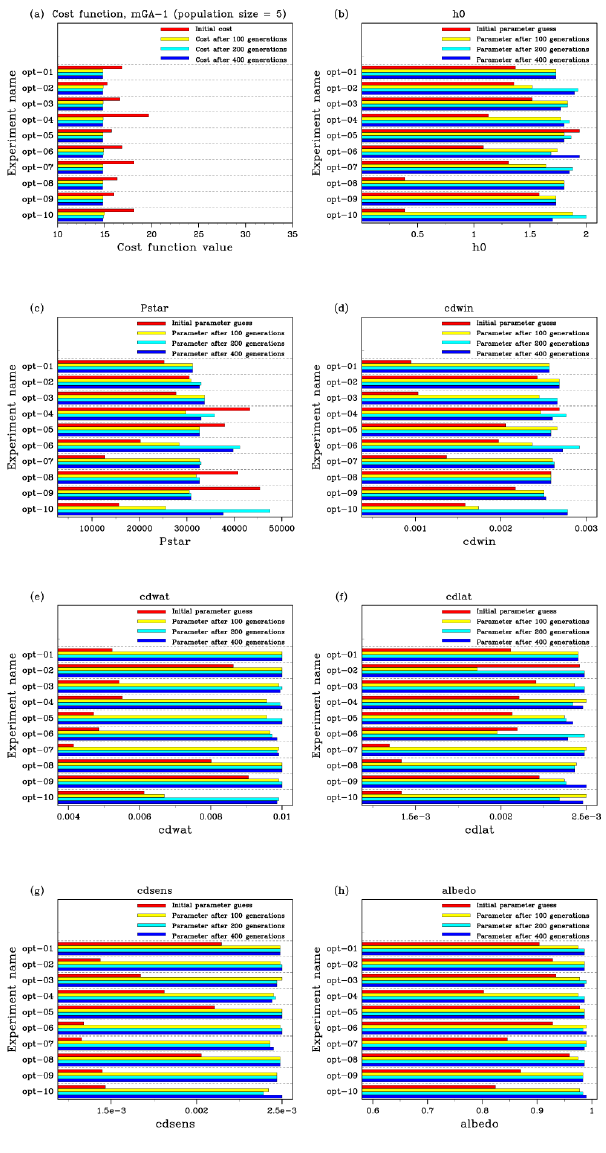
Fig. 14. The initial and optimized cost function values and associ- ated parameter values obtained from 10 independent optimization experiments with the µGA (µGA – 1; population size = 5, num- ber of possibilities = (2 7 ) 7 ) . (a) Cost function values at the initial (red) and after 100 (yellow), 200 (green) and 400 (blue) genera- tions. (b–d) Parameter values at the initial and after 100, 200 and 400 generations (the same color correspondence as (a) ). The initial cost functions and associated parameter values for respective opti- mization experiments were obtained from the best fittest individual in the first generation.